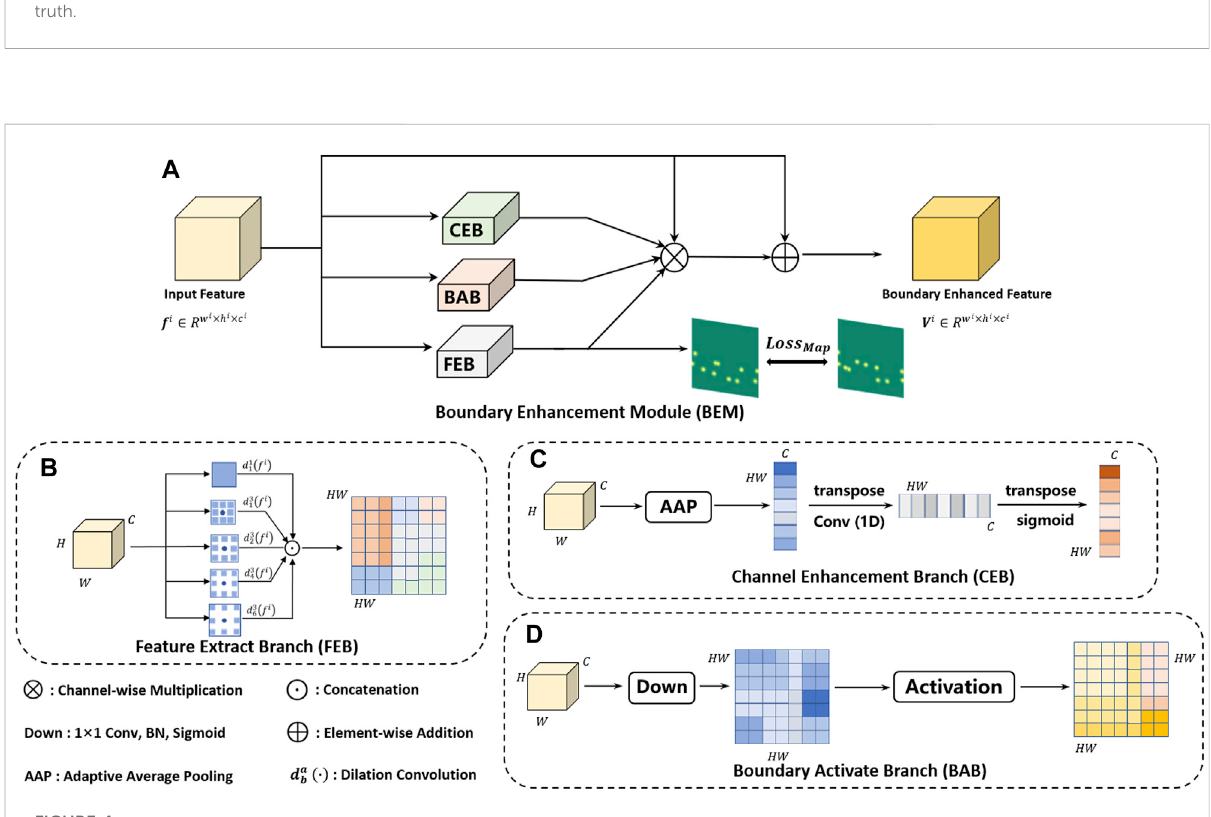
FIGURE 4 The architecture of the proposed BEM (A) . The BEM consists of three parallel branches including FEB (B) , CEB (C) and BAB (D) , which achieve enhancement of boundary information from the feature, channel and spatial perspective, respectively.